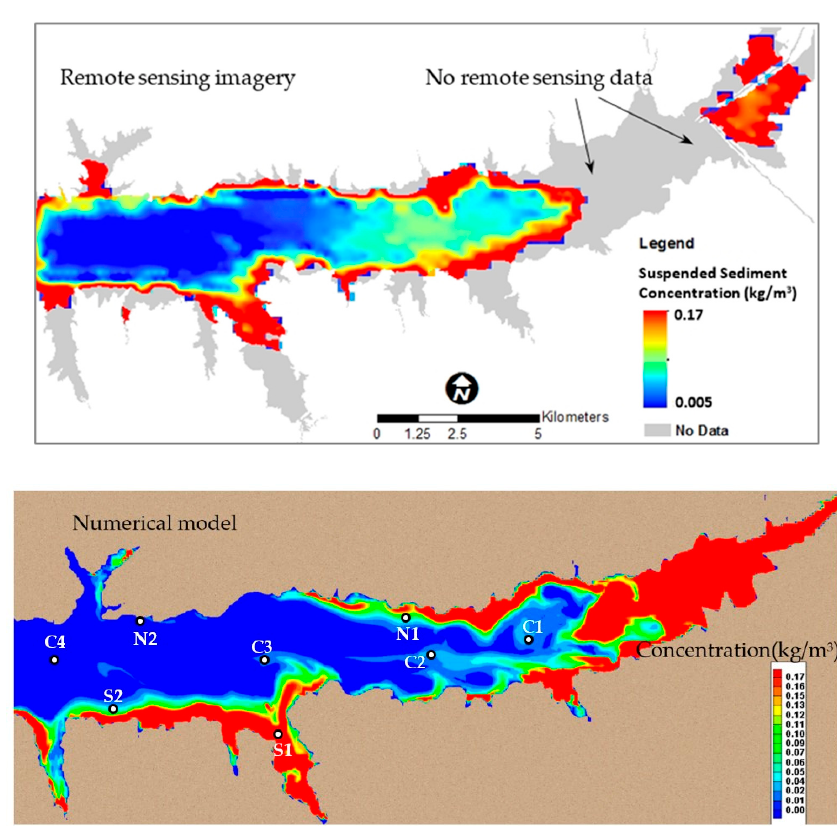
Figure 9. Comparison of SS concentrations at the water surface obtained from remote sensing technology and numerical modeling.